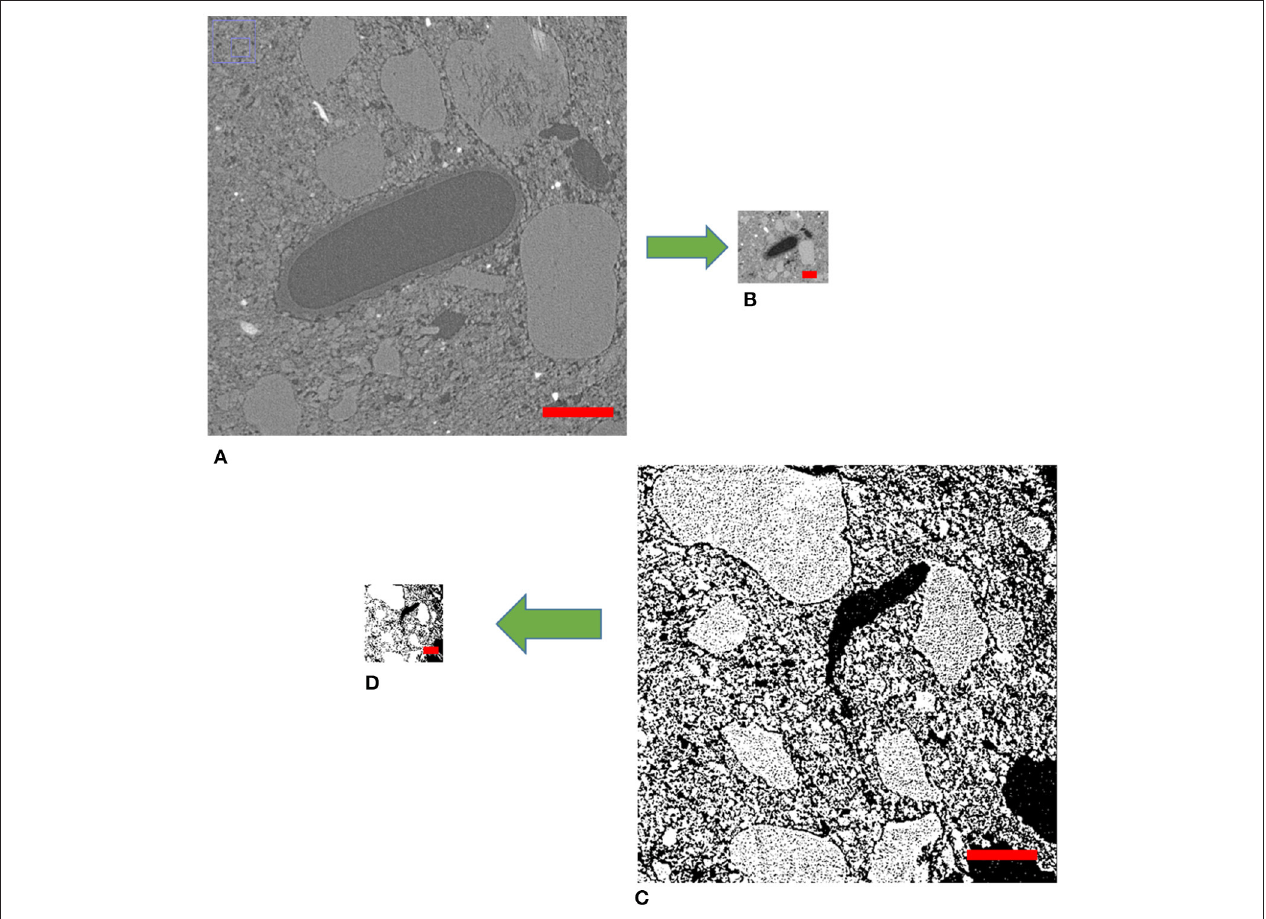
FIGURE 5 | Example of a 2 µ m image (A) and the same image reduced to 13 µ m resolution (B) . Example of thresholding with Otsu’s method of the same image at 2 µ m (C) and 13 µ m (D)